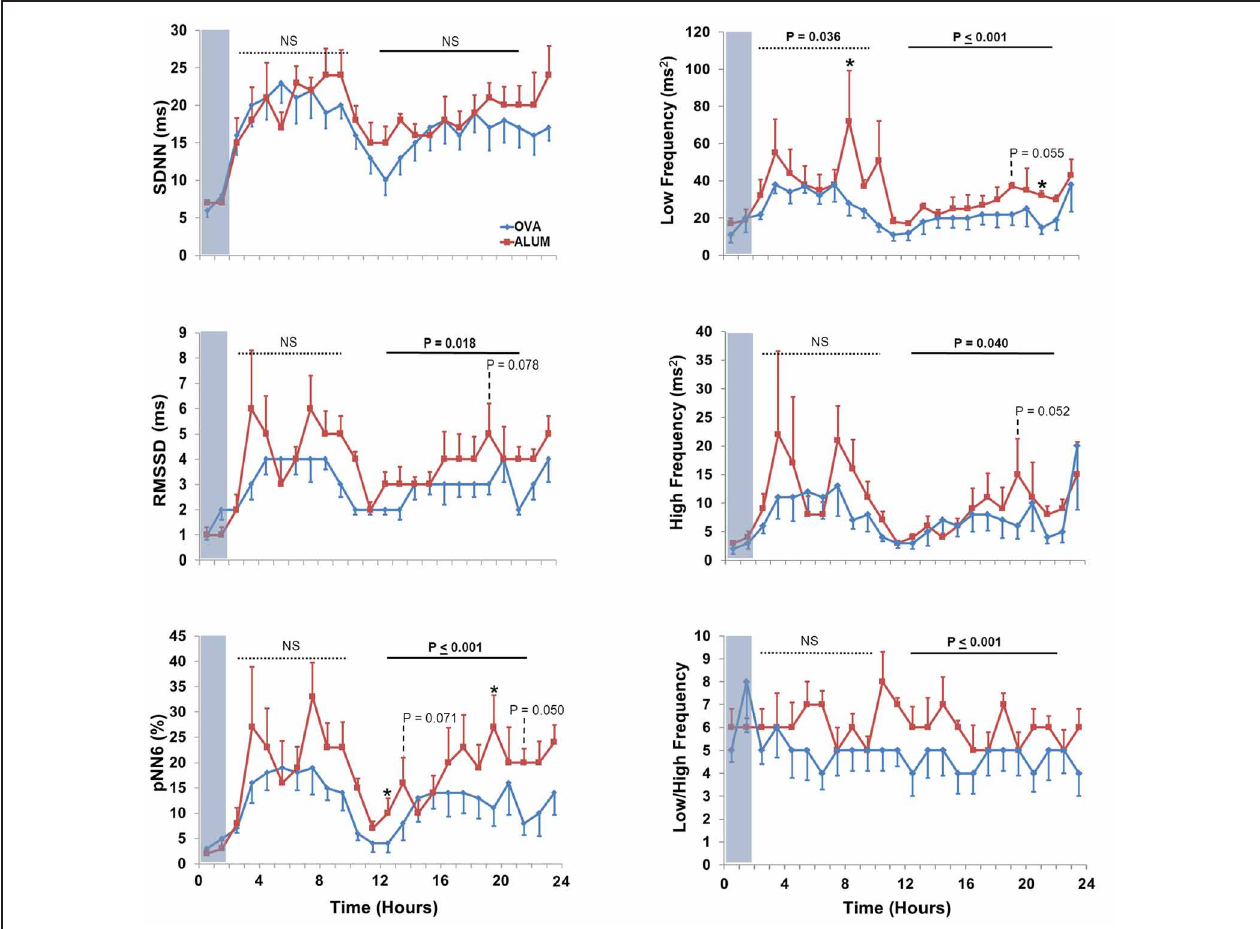
FIGURE 6 | The effect of OVA sensitization on HRV during the light and dark cycles immediately following aerosol challenge. During the light cycle, OVA sensitization resulted in decreased LF relative to Alum controls (3–10h; P < 0 . 05). During the dark cycle,